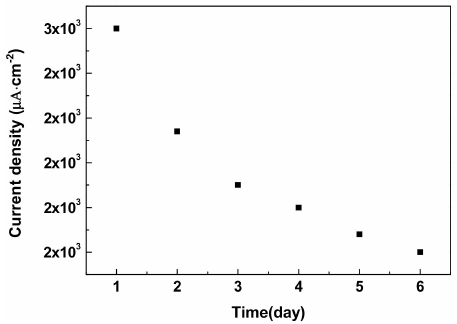
Figure 6. Amperometric response of Nafion / Cu 2 O–BSA / GCE to glucose over